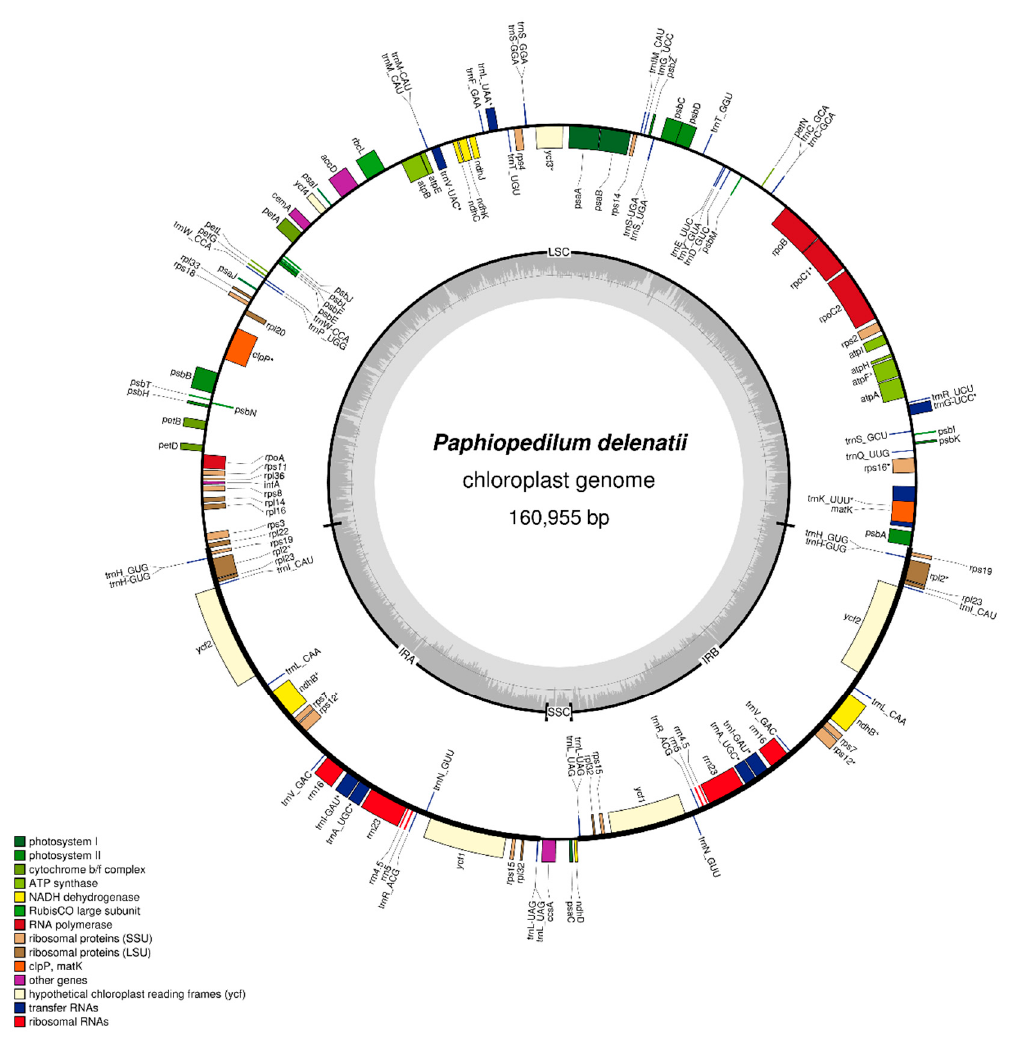
Figure 1. Gene map of the Paphiopedilum delenatii chloroplast genome. Annotated genes are colored according to functional categories. Genes lying outside of the outer circle were transcribed clockwise, while those inside the circle were transcribed counterclockwise. The innermost, darker gray corresponds to GC content, while the lighter gray corresponds to AT content. IR, inverted repeat; LSC, large single-copy region; SSC, small single-copy region; SSU, small subunit; LSU, large subunit; RNA, ribonucleic acid; NADH, nicotinamide adenine dinucleotide (NAD) + hydrogen (H); ATP, Adenosine Triphosphate; RubisCO, Ribulose-1,5-bisphosphate carboxylase/oxygenase.